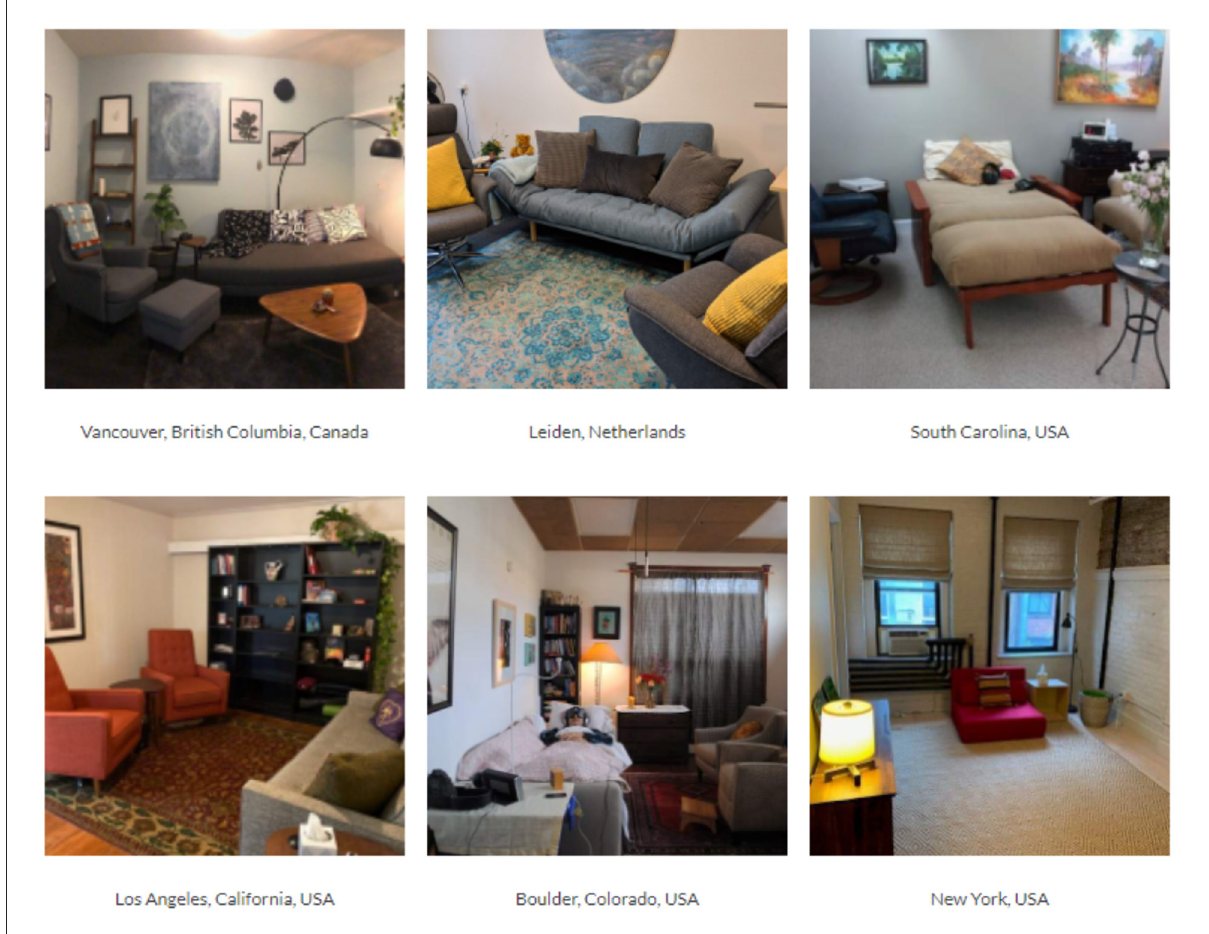
FIGURE1 Photographs of MDMA-assisted therapy clinical trial settings.